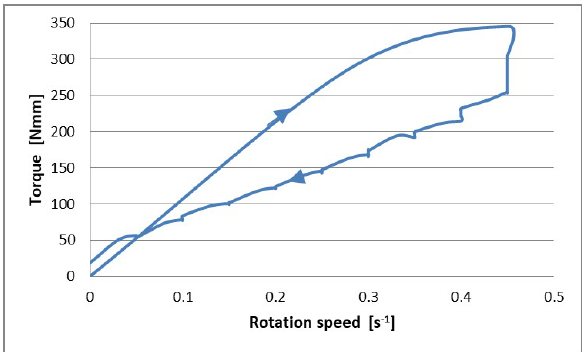
Figure 6: A typical flow curve output from the Viskomat XL measured after 10 minutes (12 mm Fib1, dosage 0.6 kg per 1 m 3 ).